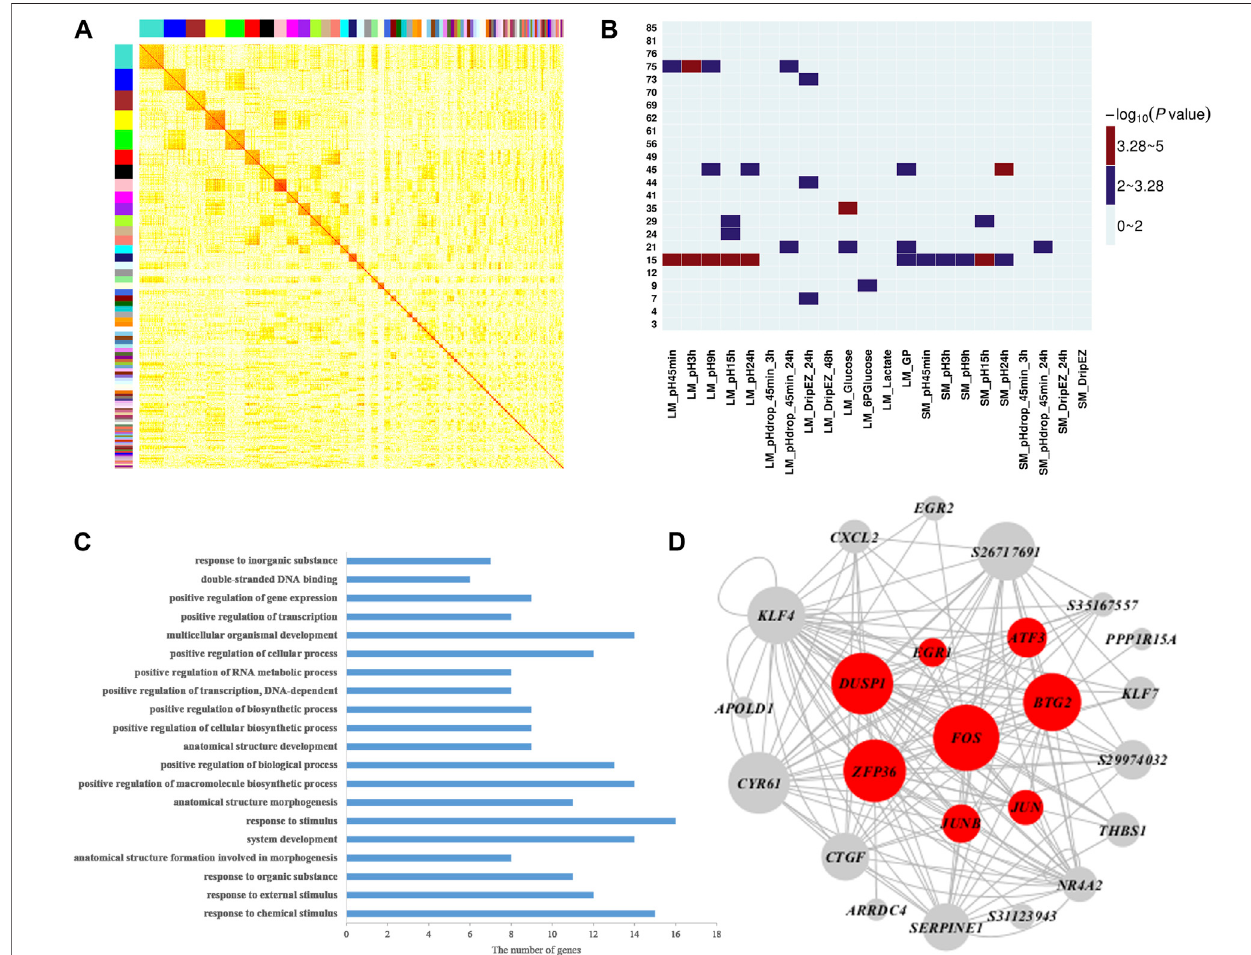
FIGURE 2 | Weighted gene co-expression analysis of 17,822 transcripts in muscle. (A) Heat map for muscle tissue co-expression network. Each module is assignedauniquecolor.Themodulesareorderedbysize,andthegeneswithinmodulesintherowsandcolumnsaresortedaccordingtotheirintramodularconnectivity. (B) Heatmap representing the signi fi cance ( − log10 p -value) of the correlation between muscle network modules and 22 meat quality traits in muscle. (C) Functional annotation of module 15 genes by gene ontology (GO) analysis. The bar plot represents the gene counts within each GO category. All function or process terms listed have enrichment of corrected p values < 0.05. (D) Visualization of module 15; the top 150 connections sorted by correlation coef fi cients among transcripts are shown for each module. Nodes correspond to genes. When the gene symbols are unknown, transcript IDs are shown. The size of nodes represent their intramodular connectivity. Nodes in red within a module represent genes involved in glycogen metabolism pathway enriched in module